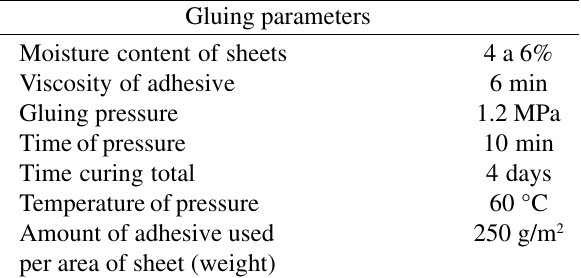
Table 1. Gluing parameters for plywood manufactured with cas- tor-oil polyurethane